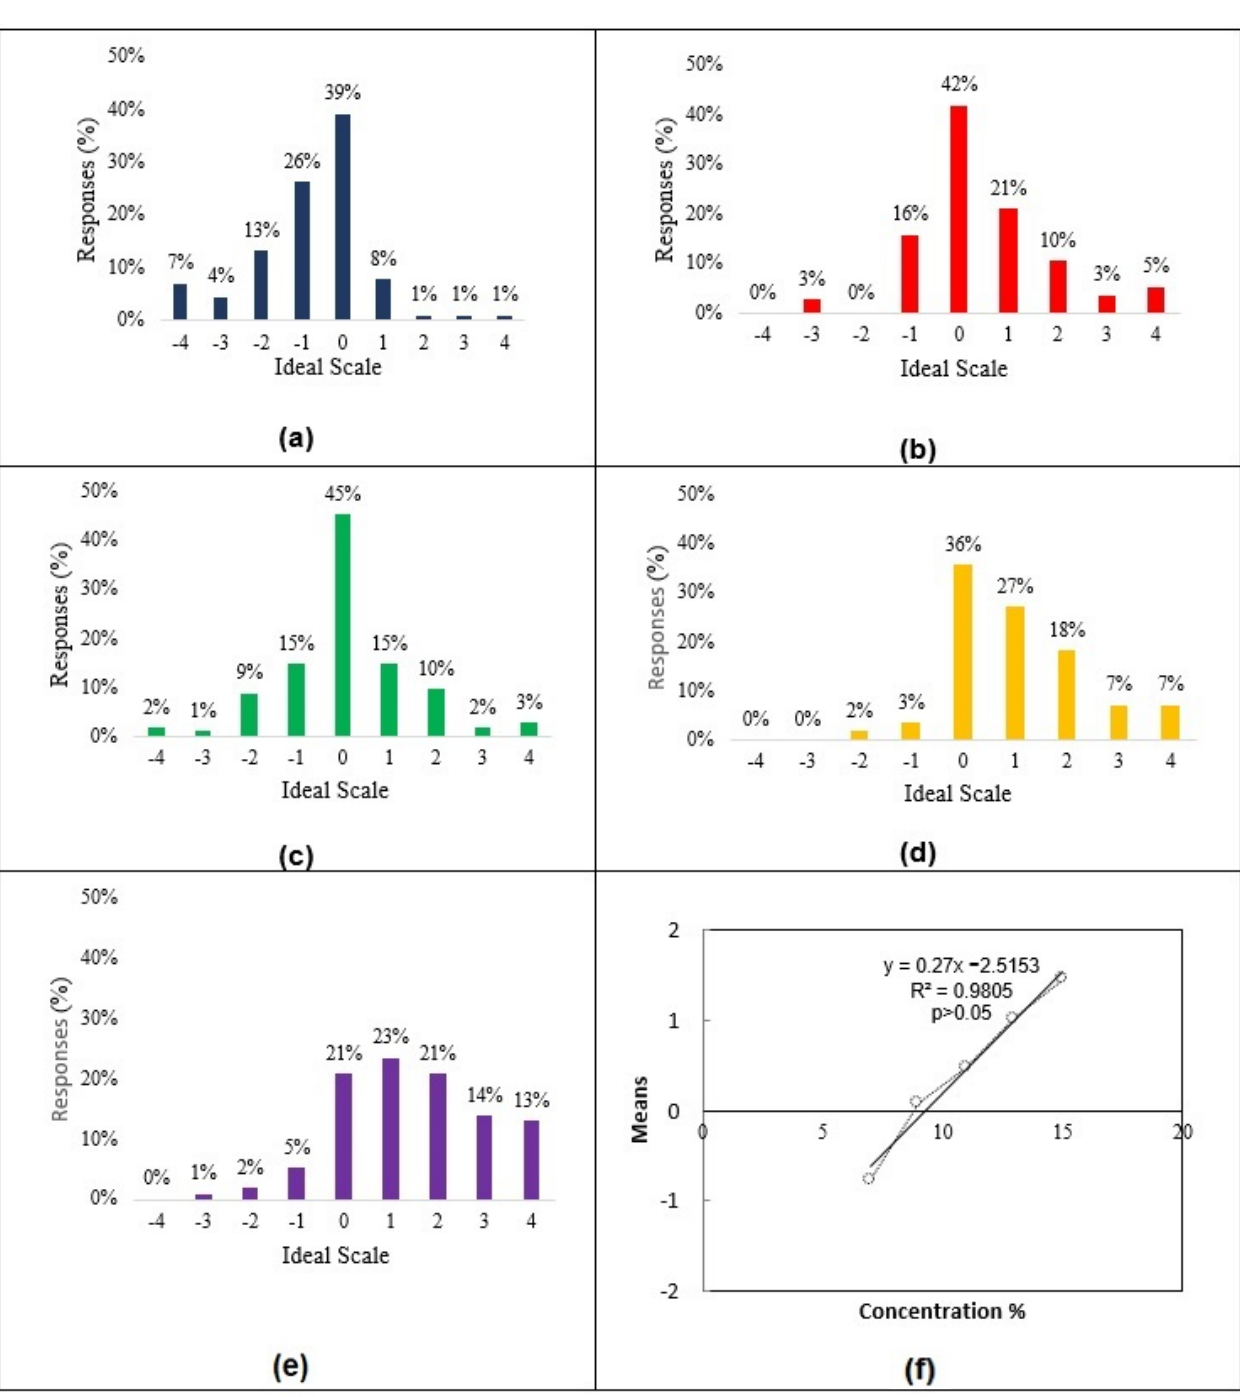
Figure 1. Histogram of the responses for the Ideal Sweetness test, with different sucrose concentrations: 7.0% ( a ) blue bars, 9.0% ( b ) red bars, 11.0% ( c ) green bars, 13% ( d ) yellow bars, and 15% ( e ) purple bars, and straight-line graph and equation obtained from linearizing the Ideal Sweetness test results ( f ).